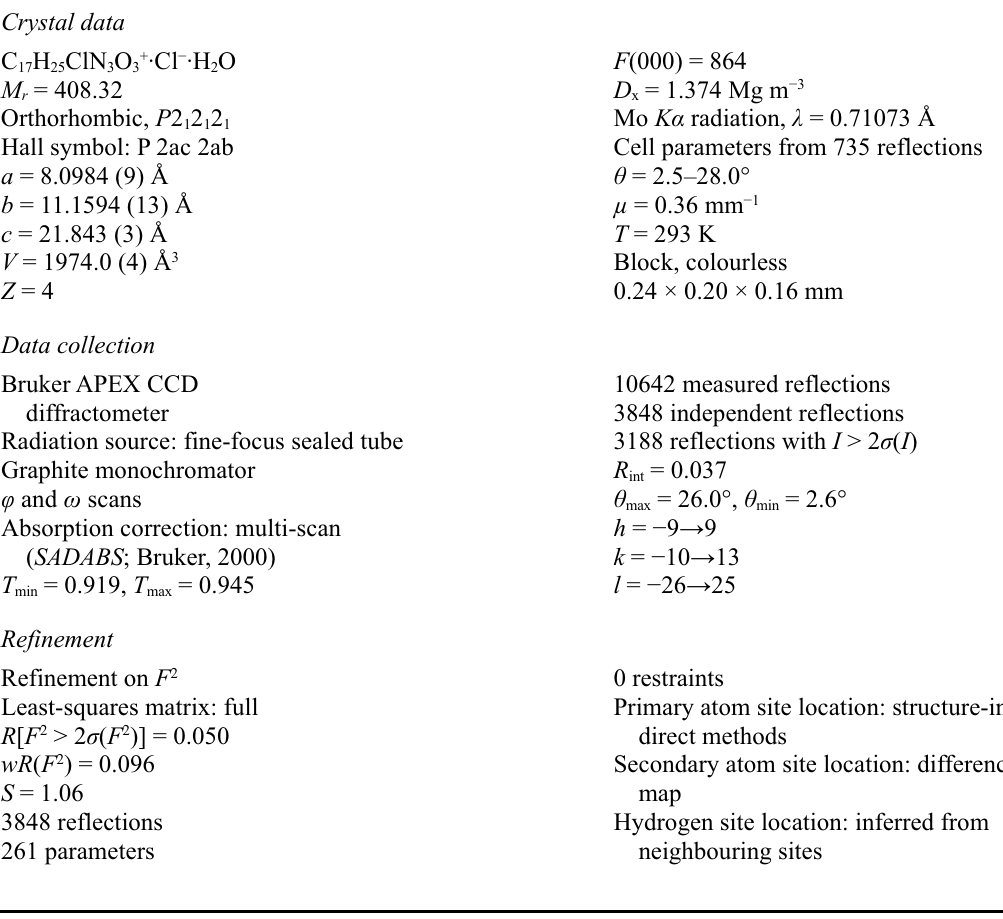
Molecular structure of the title compound with 30% displacement ellipsoids for non-H atoms. 3-[(4-Amino-5-chloro-2-ethoxybenzamido)methyl]pyrrolo[2,1- c ][1,4]oxazin-5-ium chloride